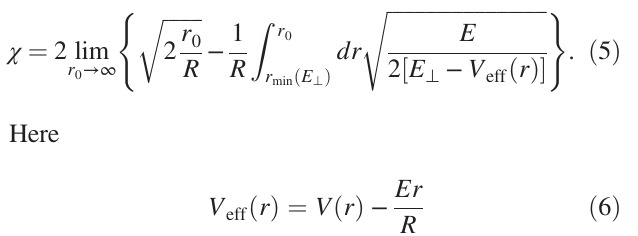
FIG. 1. Solid curve, effective potential V Its red regions signify loci of radial reflection points of VR particles coming from and returning to r → þ ∞ with a constant E ⊥ . Red curve segments combined with the horizontal dotted lines show behavior of function max segments mark intervals contributing to the mean VR